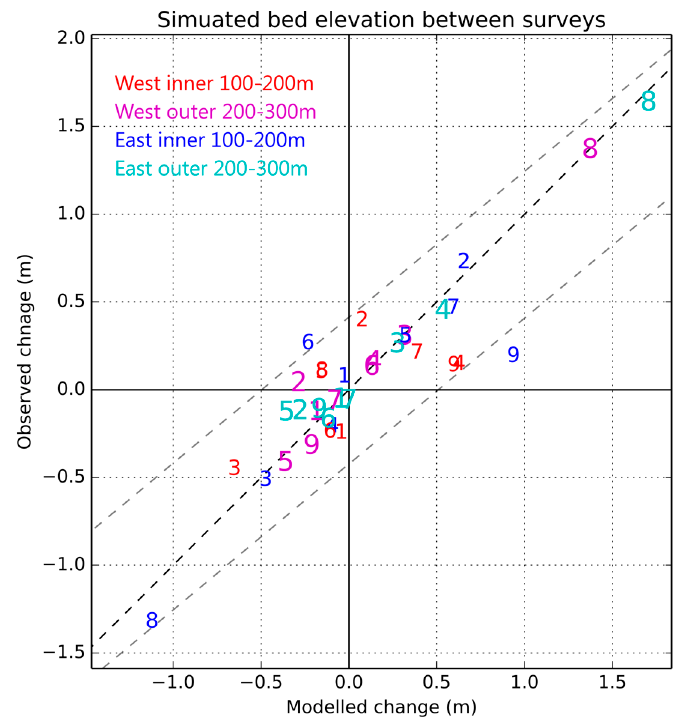
Figure 4. Model bed evolution validation in the location of the storm-bar and trough at both single-beam survey sites. Plotted are the model bed elevation median changes over the first nine simulations (10 surveys over 33 months). The dashed grey line is plus or minus one standard deviation of a linear fit to all data. The dashed black line is the one-to-one line.